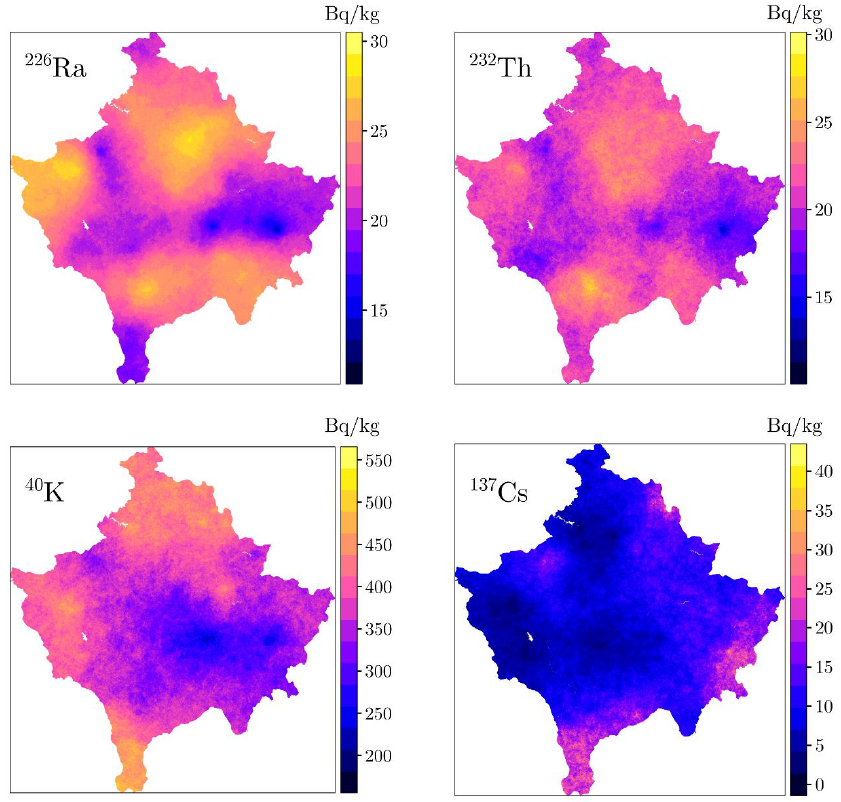
Figure 5. Distributions of radioactivity concentration for 226 Ra, 232 Th, 40 K, and 137 Cs.